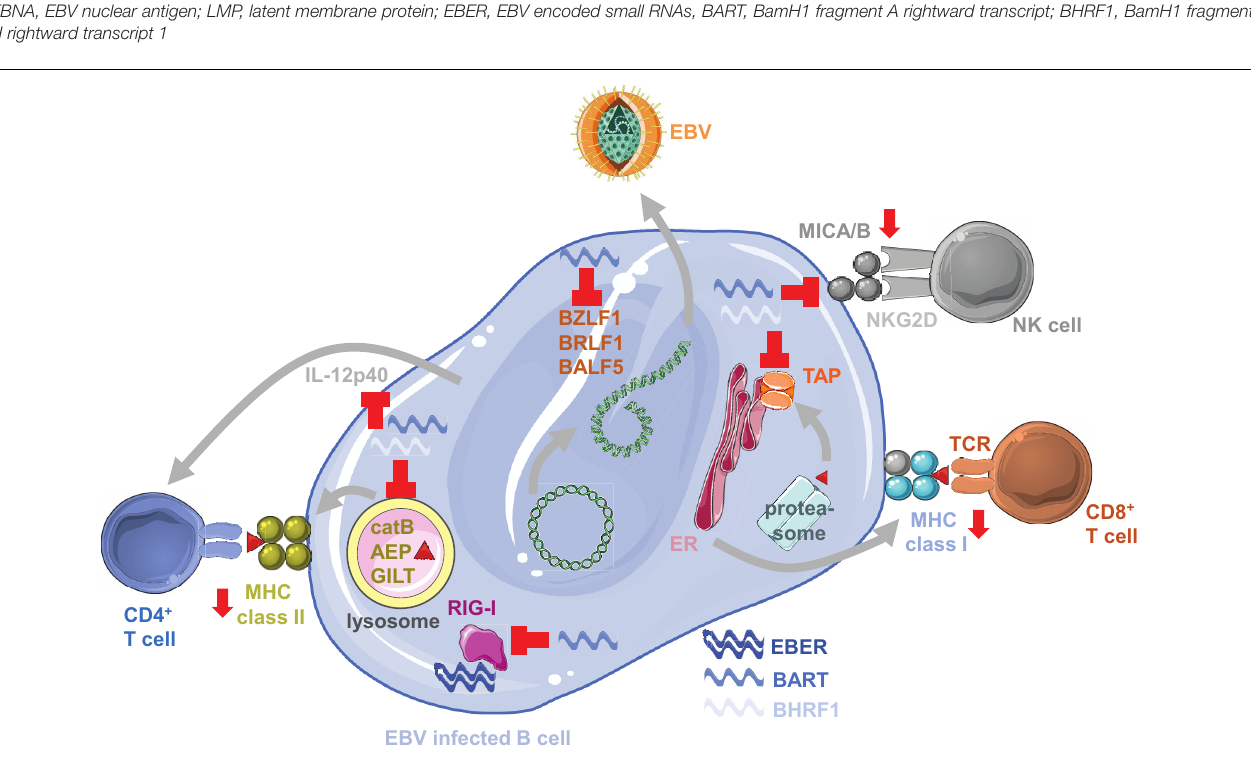
FIGURE 1 | Immune modulation by EBV ncRNAs. BART miRNAs block lytic EBV reactivation by down-regulating BZLF1, BRLF1 and BALF5, limiting viral antigen production for immune responses. BART miRNAs block also MICA/B expression to inhibit NKG2D mediated NK cell recognition of EBV infected B cells. BHRF1 and BART miRNAs compromise antigen presentation by MHC class I molecules by down-regulating the transporter associated with antigen processing (TAP) to load MHC class I complexes with proteasome products in the endoplasmic reticulum (ER) for stimulation of CD8 + T cells. EBERs can be recognized by innate immune sensors of RNA like RIG-I, but the RIG-I pathway is also down-regulated by BART miRNAs. MHC class II ligand generation by lysosomal proteolysis is inhibited by BHRF1 and BART miRNAs down-regulating cathepsin B (catB), asparaginyl endopeptidase (AEP) and IFN- γ –inducible lysosomal thiol reductase (GILT). T cell priming and NK cell activation is also compromised by BHRF1 and BART miRNAs blocking IL-12p40 production. This figure was created in part with modified Servier Medical Art templates, which are licensed under a Creative Commons Attribution 3.0 unported license: